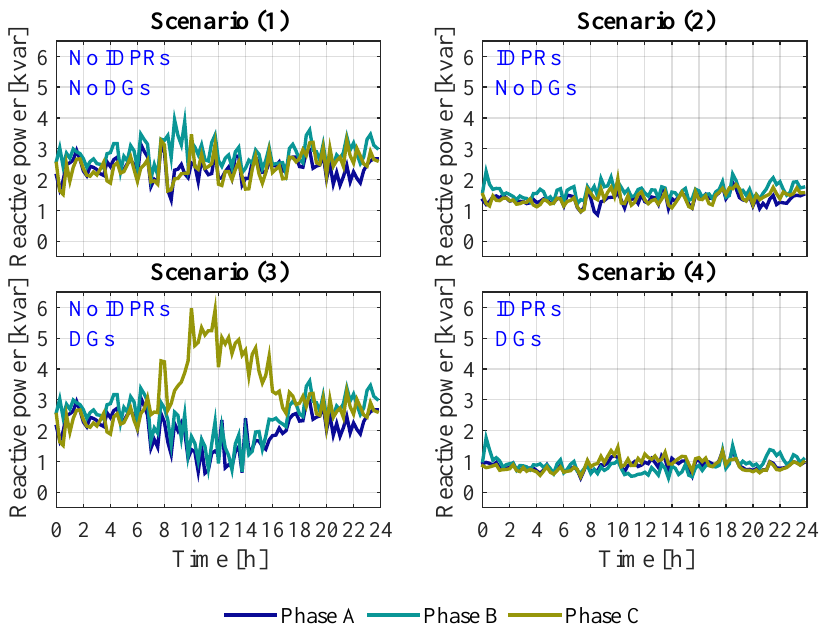
Figure 13. Net reactive power exchanged per phase with the external grid by the PN with and without including IDPRs.